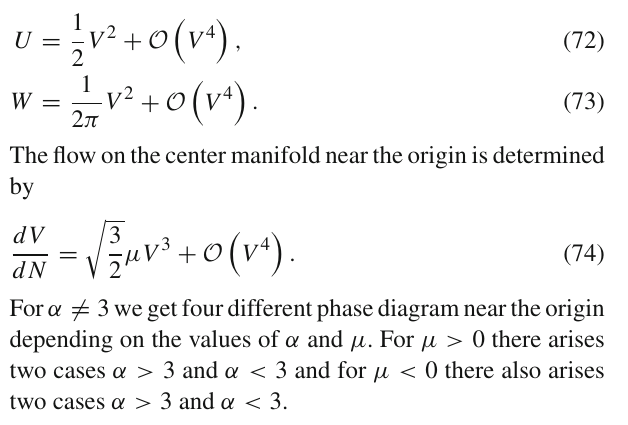
Fig. 11 Vector field near the origin in UV plane for the critical point P 5 . L.H.S. figure is for ( α < 3 ,μ > 0) and R.H.S. figure is for ( α > 3 ,μ >